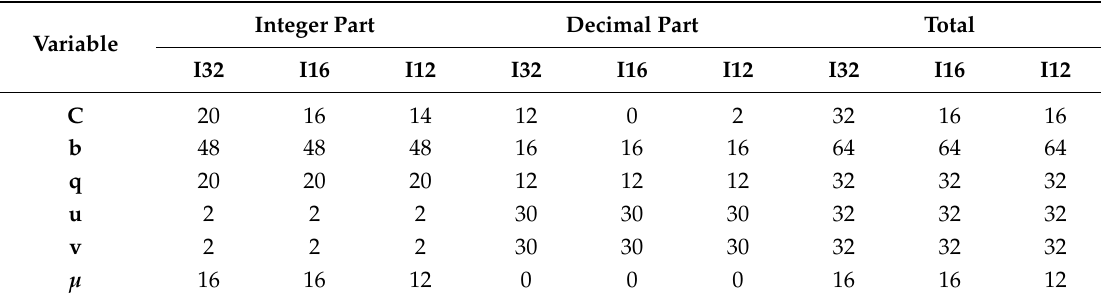
Table 1. Number of bits used for the integer and decimal parts used to represent the variables involved in the HyperLCA Transform . Three versions of the algorithm were developed to use integer arithmetic (I32, I16, I12). Integer Part Decimal Part Total Variable I32